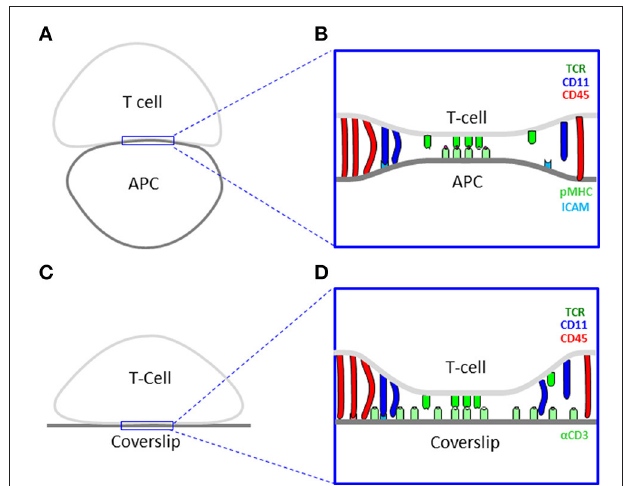
FIGURE 1 | Cell interfaces of the immune synapse. (A) A scheme of a physiological interface between a T cell and an antigen presenting cell (APC). (B) A physical model of the interface in panel (A) . (C) A scheme of an experimental interface between a T cell and a coverslip. (D) A physical model of the interface in panel (C)